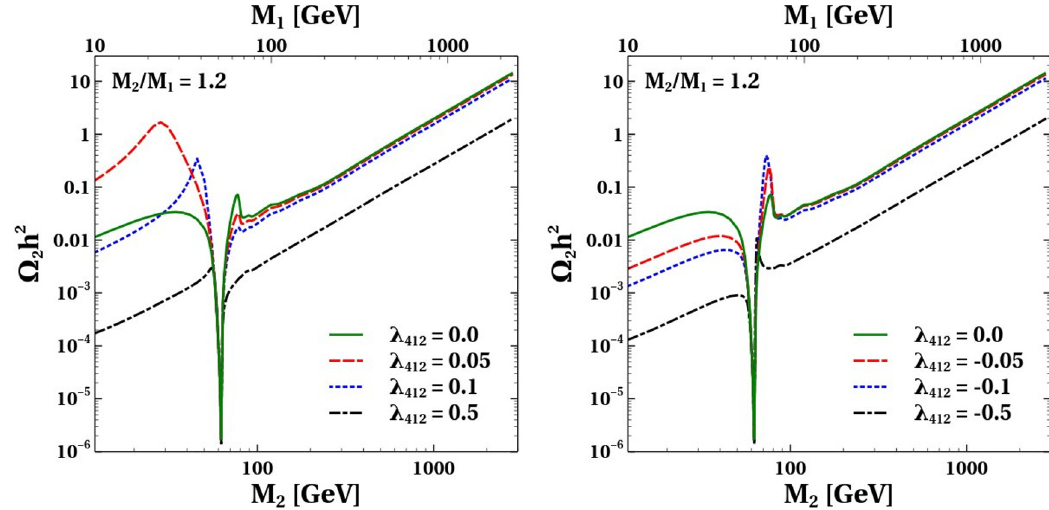
Figure 5 . The e(cid:11)ect of (cid:21) 412 on (cid:10) 2 for M 2 =M 1 = 1 : 2. The di(cid:11)erence between the left and the right panel is just the sign of (cid:21) 412